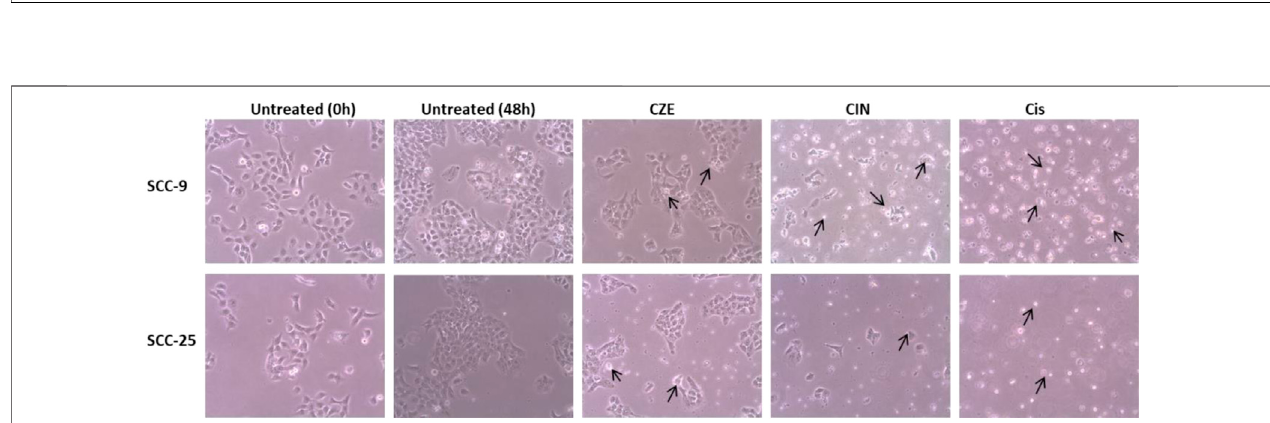
FIGURE 2 | Photomicrographs showing morphological changes in OSCC cells after CZE and CIN treatment at 48 h. As shown by arrows, the cells were smaller, detached from culture plates, lost their original shape and showed membrane blebbing. Cinnamomum zeylanicum extract (CZE), cinnamaldehyde (CIN) and Cisplatin (Cis). CZE and CIN inhibited the colony-forming potential of OSCC